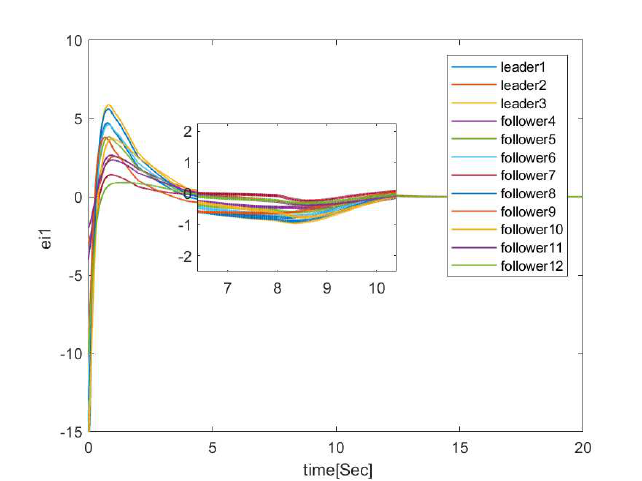
Figure 6. Position State Component 1 of Agent with hierarchical delay.